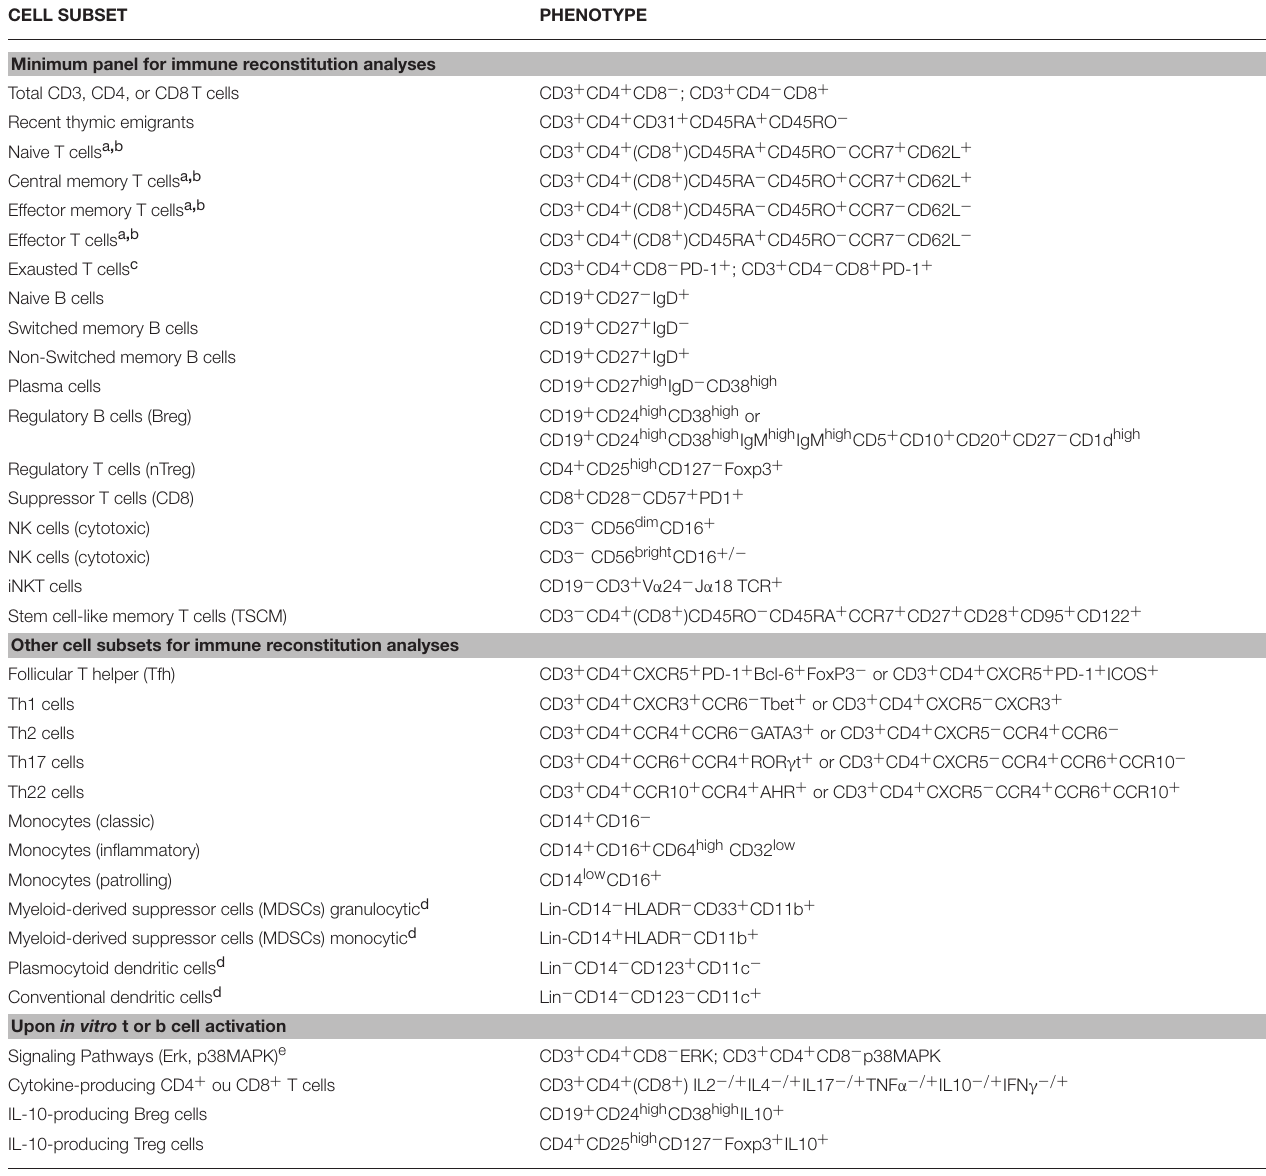
TABLE 3 | Immunophenotyping of peripheral blood cell subsets in patients with AD undergoing AHSCT. CELL SUBSET